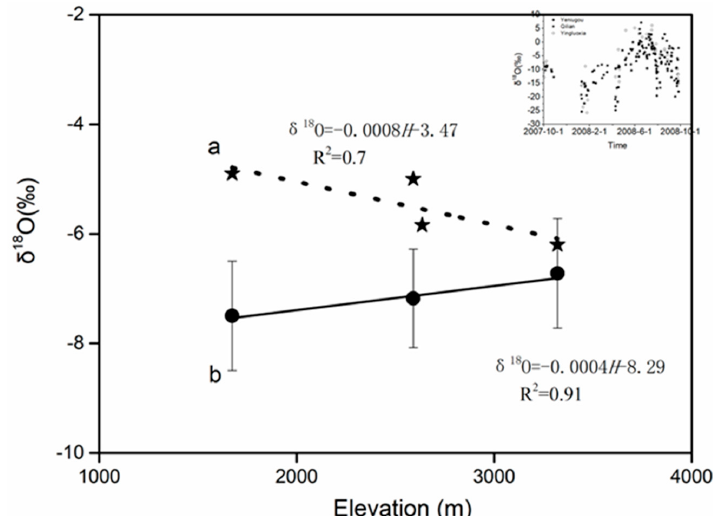
Figure 3. The δ 18 O variability with elevation during sampling between 2007.10 and 2008.9 in the upper reaches of the Heihe River Basin in the Qilian Mountains. Error bars represent the relative standard deviation (RSD). The inset shows the δ 18 O values for individual precipitation events in the three sampling sites. a: 2006.5–2007.5 (from Ninglian Wang et al. [18]); b: 2007.10–2008.9 (this study).